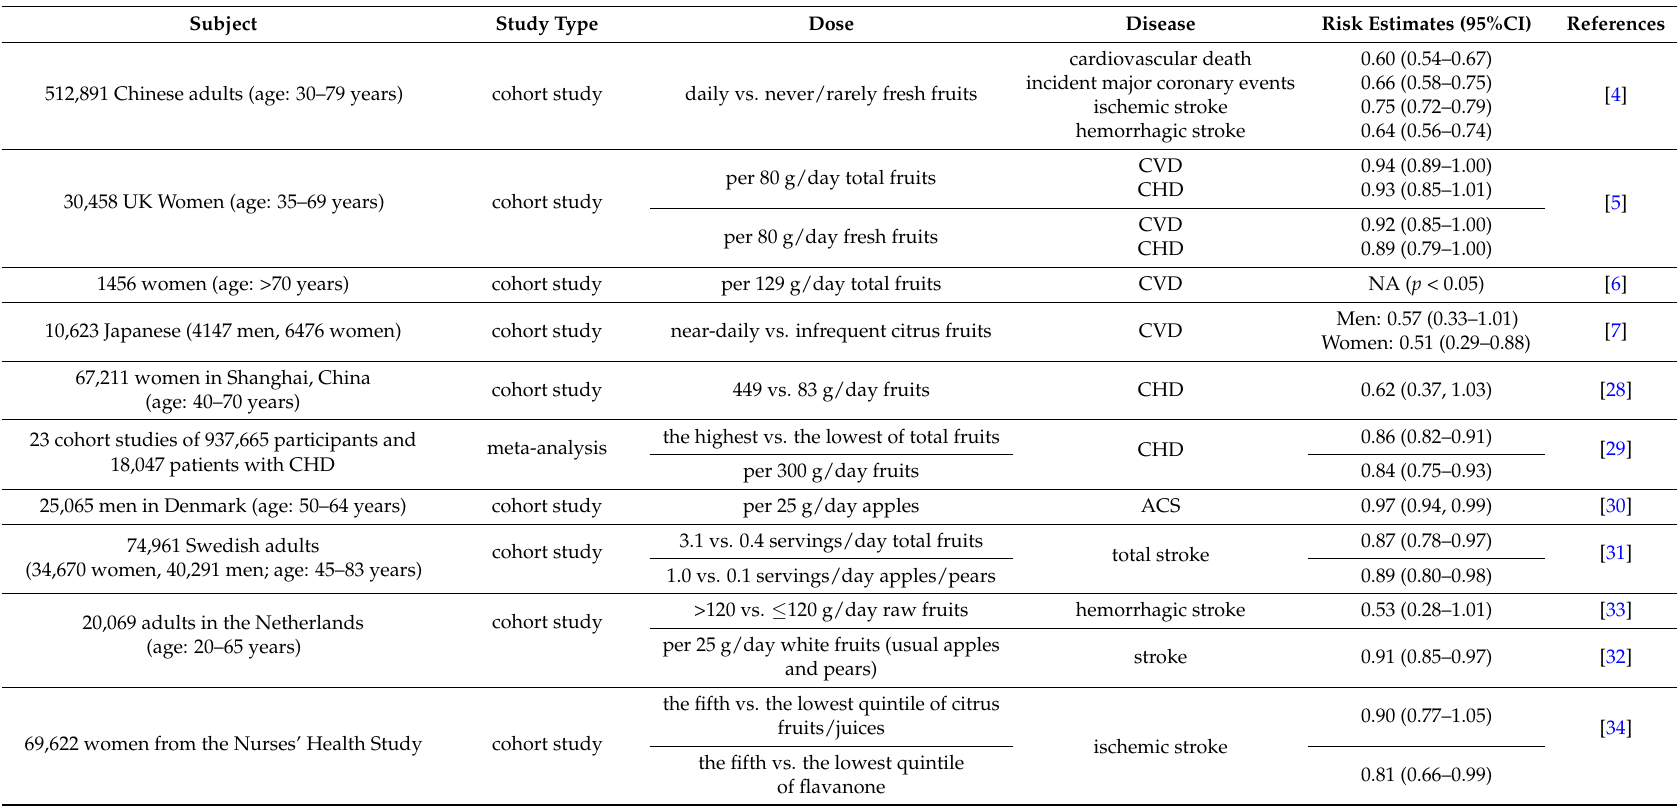
Table 1. Fruit intake and CVD